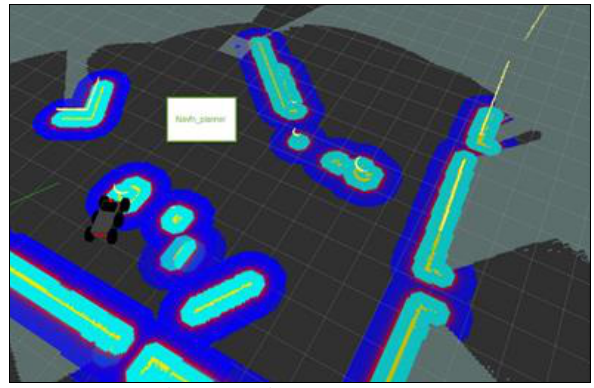
Figure 10. Performance of Dijkstar algorithm on a cost map